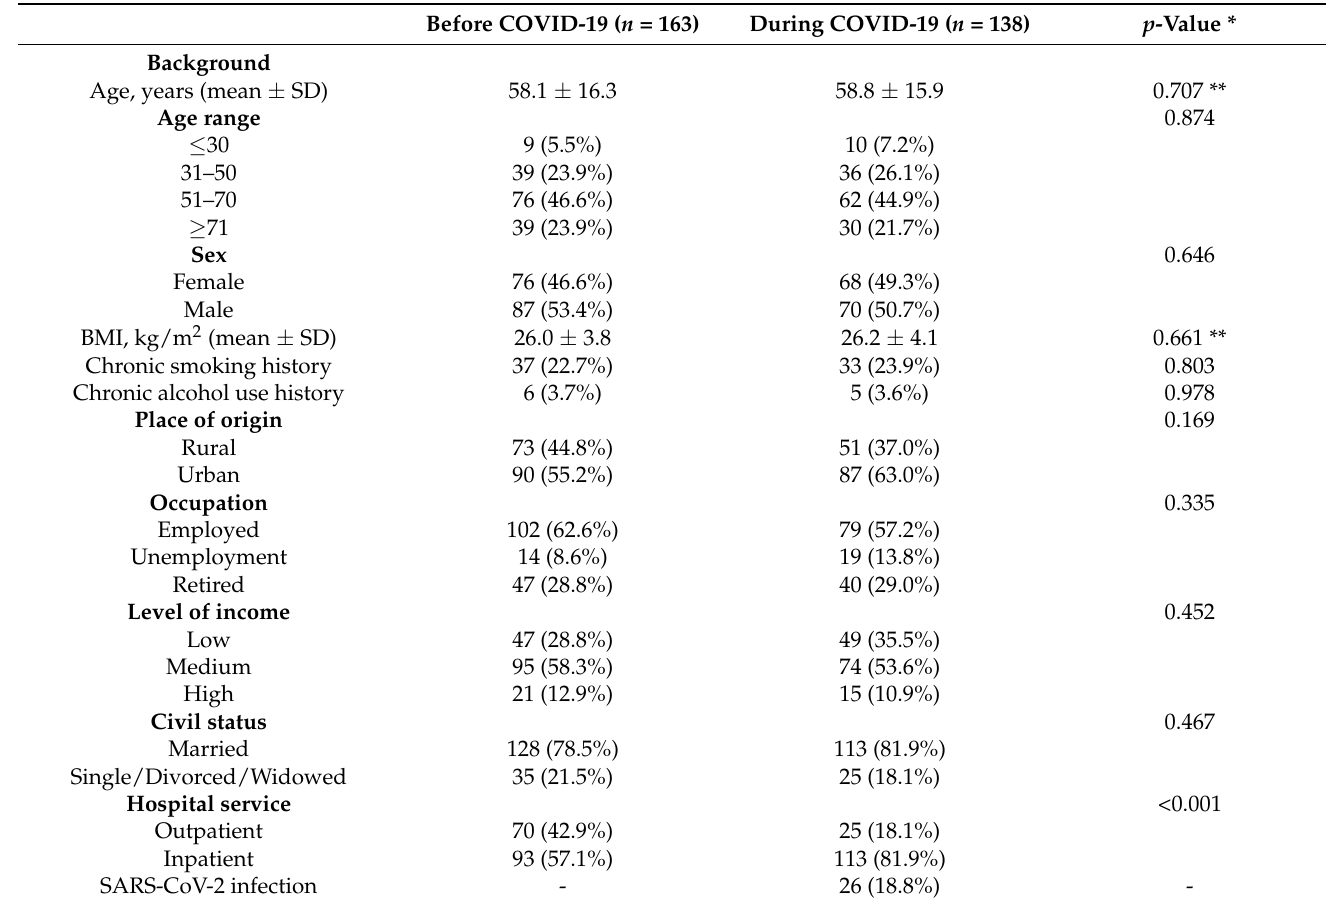
Table 1. Comparison of baseline characteristics of patients with malignant melanoma before and during the COVID-19